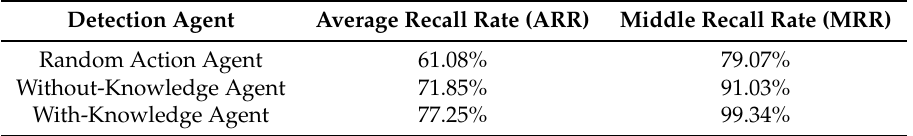
Table 2. Performance of different detection agents.